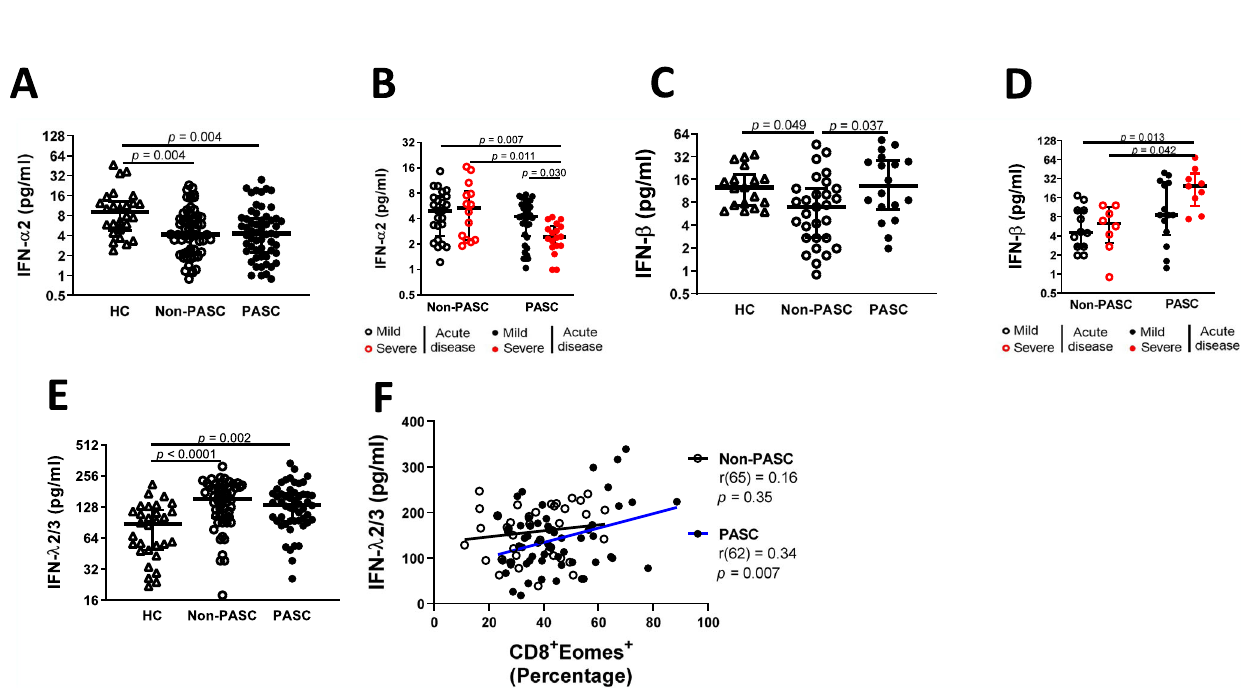
Fig. 5 | Higher IFN-beta and IFN-lambda levels are associated with PASC. The plasma levels of IFN- α 2 ( A ), IFN- β ( C ) and IFN- λ 2/3 ( E ) of HC ( n =37), non-PASC ( n =65) and PASC ( n =62) individuals and sub-divided by mild or severe acute disease ( B and D for IFN- α 2 and IFN- β , respectively). Spearman ’ s correlation between the percentage of IFN- λ 2/3 and CD8 + EOMES + for non-PASC and PASC β 7 integrin on CD8 + T cells, a useful surrogate in the blood for esti- mating intestinal T cell homing 82,83 . Of interest, statistical differences were found among groups (H =8.21, p =0.016, η 2 H = 0.047). Our results indicated that both non-PASC and PASC individuals display lower percentages of CD8 + β 7 Integrin + T cells when compared to HC ( p = 0.016and p =0.034forNon-PASCandPASC,respectively;Fig.6A).